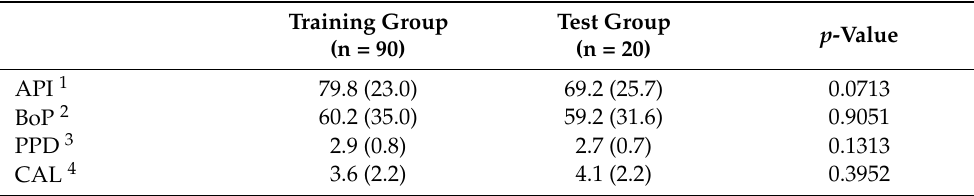
Table 5. Periodontal assessments for the training and the test